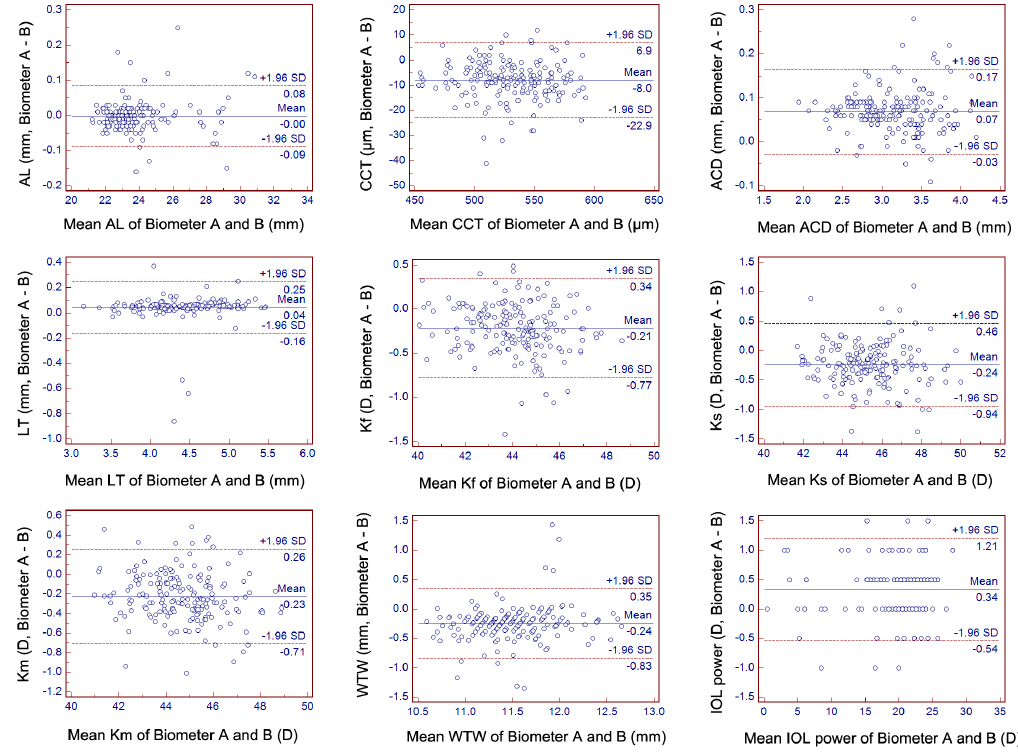
Figure 4. The agreement of axial length (AL), central corneal thickness (CCT), anterior chamber depth (ACD), lens thickness (LT), flat keratometry (Kf), steep keratometry (Ks), mean keratometry (Km), white-to-white (WTW) distance, and intraocular lens (IOL) power measured using biometers A and B (Bland–Altman plots). The mean difference is demonstrated with the continuous line, whereas the 95% limit of agreement is indicated with dashed lines. Table 3. The linear regression formulas and correlations for the anterior segment parameters in both devices. Linear Regression Formula